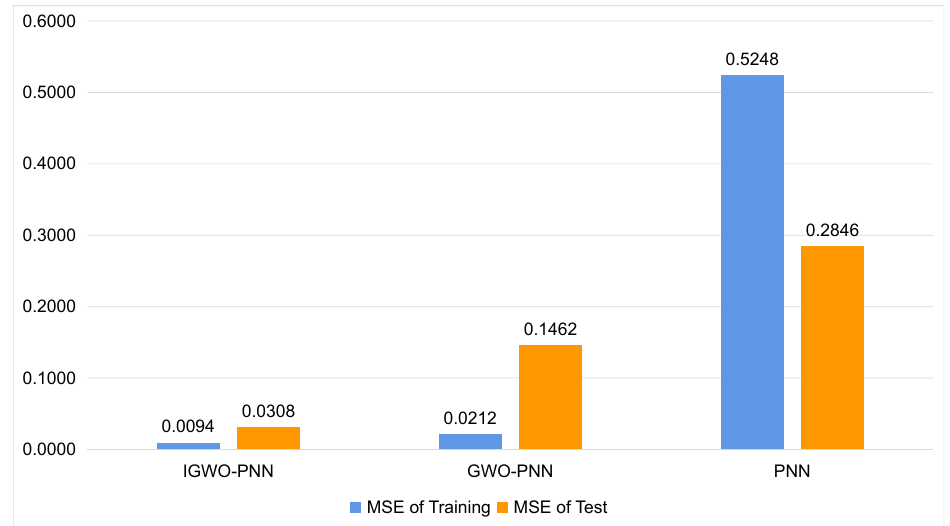
Figure 7. Comparison of the mean square error (MSE) of the first set of comparison experiments.